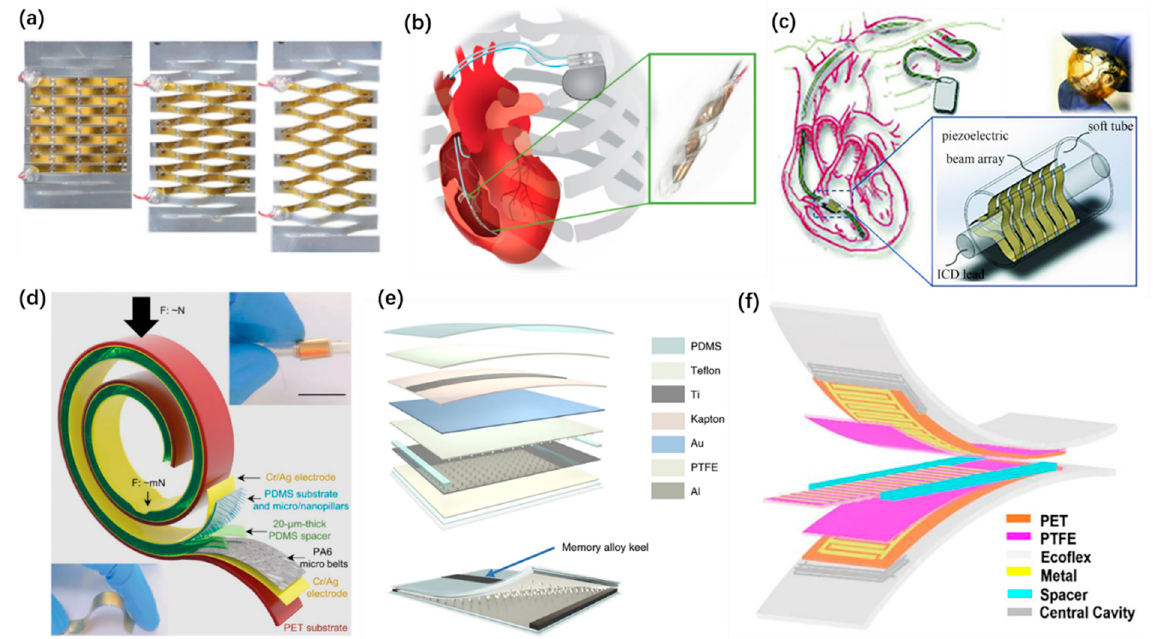
Figure 5. Structures of implantable nanogenerators. ( a ) A kirigami inspired PENG. Reproduced with permission from Ref. [83] . Copyright © 2019, Wiley-VCH. ( b ) A helix structured PENG. Reproduced with permission from Ref. [116]. Copy- right © 2019, Elsevier. ( c ) A PENG with buckled beam array structure. Reproduced with permission from Ref. [114] .